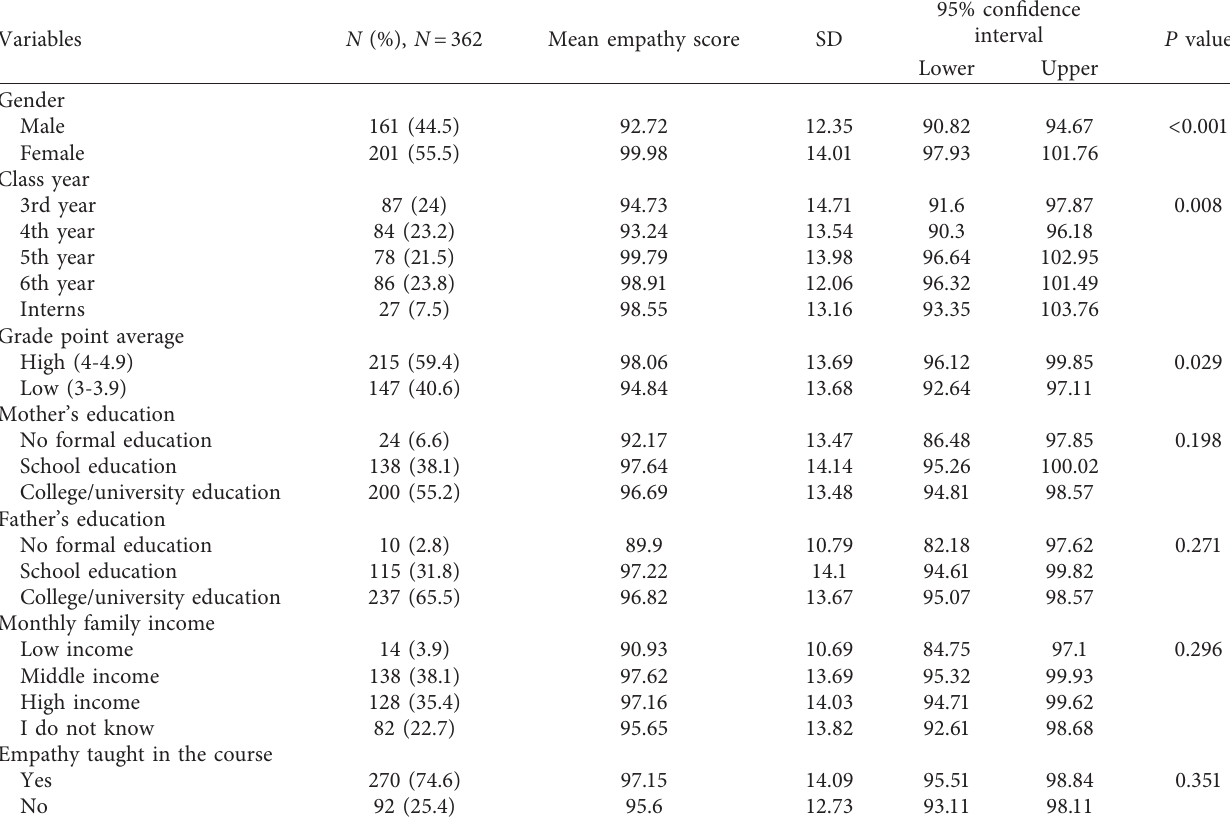
Table 1: Association between various sociodemographic factors and empathy among